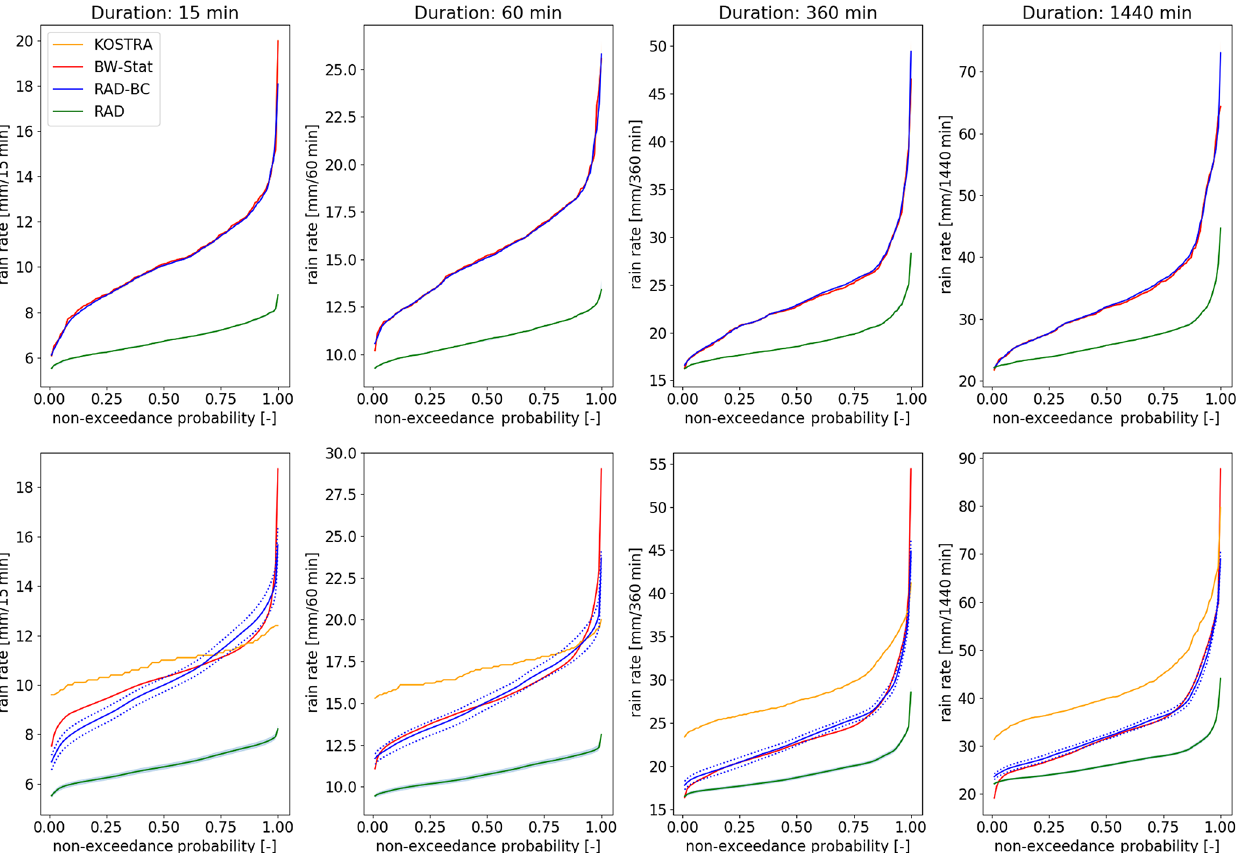
Figure 3. Spatial cumulative frequency distributions (CFDs) of the location parameter for four different event durations when comparing stations and radar data at the location of stations only (upper row) and integrated over the whole of BaWu (bottom row). The dotted blue lines in the bottom row represent the range of the five ensemble members (sampling uncertainty only, no